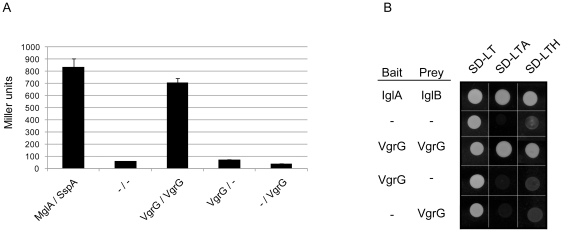
VgrG forms homodimers.(A) Bacterial 2-Hybrid analysis of VgrG-VgrG interactions. Contact between VgrG proteins fused to Zif and to the ω subunit of E. coli RNAP, induces transcription from the lacZ promoter of the E. coli reporter strain KDZif1ΔZ, resulting in β-gal activity. The negative control corresponds to vectors without insert, while the positive control is MglA-SspA [61]. Shown is the mean β-gal activity ± standard deviation in Miller units produced from three independent experiments, where two independent transformants were tested on each occasion. (B) Yeast Two-hybrid analysis of VgrG-VgrG interactions. VgrG fused to the GAL4 activation domain of plasmid pGADT7 or the GAL4 DNA-binding domain pGBKT7 were co-transformed into the S. cerevisiae reporter strain AH109. VgrG dimer formation results in activation of the ADE2 and HIS3 reporter genes, to allow growth of yeast on minimal SD medium devoid of adenine (-LTA) and histidine (-LTH) respectively at 30°C. The negative control corresponds to vectors without insert, while the positive control is IglA-IglB [14]. Results reflect trends in growth from three independent experiments in which several individual transformants were tested on each occasion.